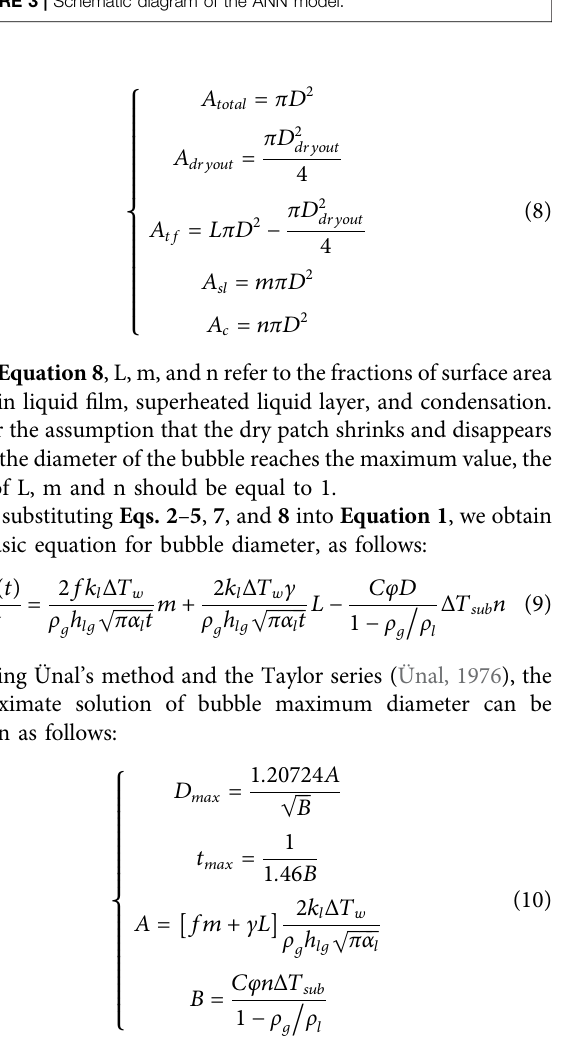
FIGURE 3 | Schematic diagram of the ANN